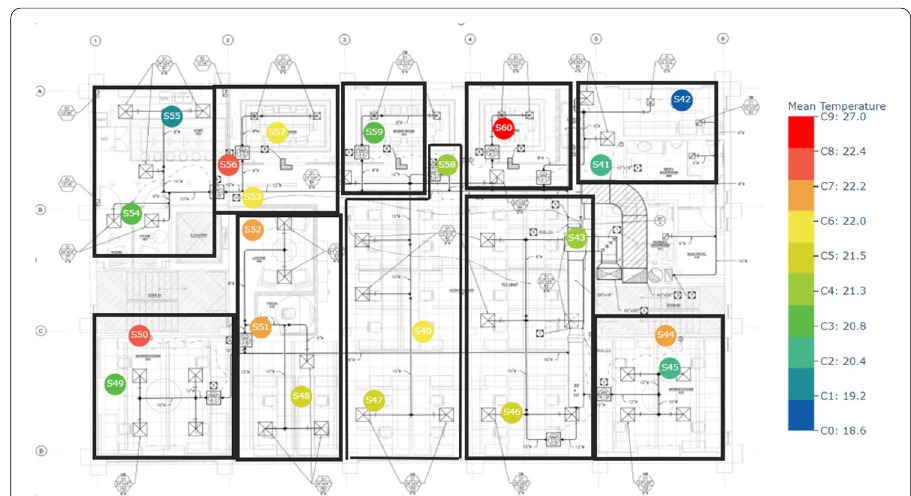
Fig. 8 K-means cluster results with zones in floor 4. Legend shows the mean temperature values of each cluster